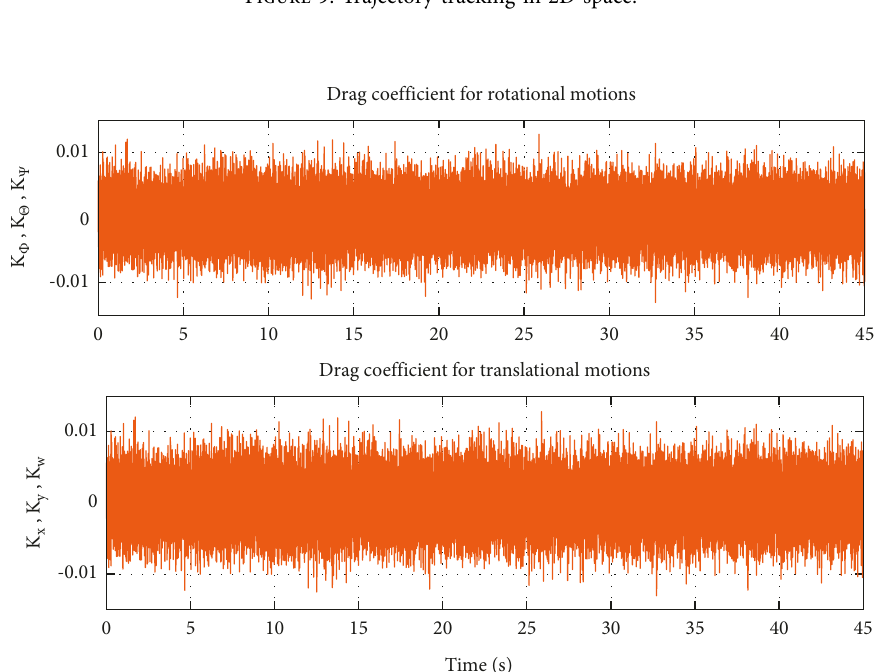
Figure 10: Variation of random drag